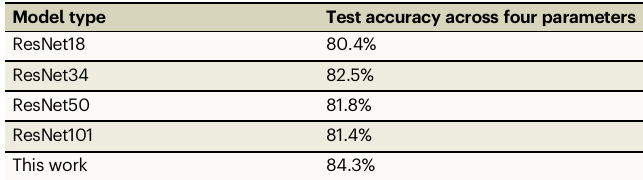
Table 1 | Comparison of model size and types and their respective test set accuracies across all four parameters Model